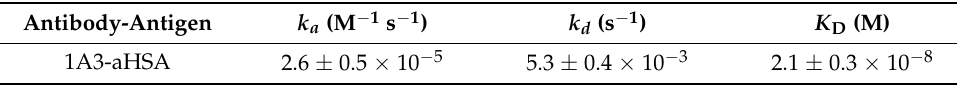
Table 3. Kinetic binding parameters of the interaction of 1A3 with aHSA.